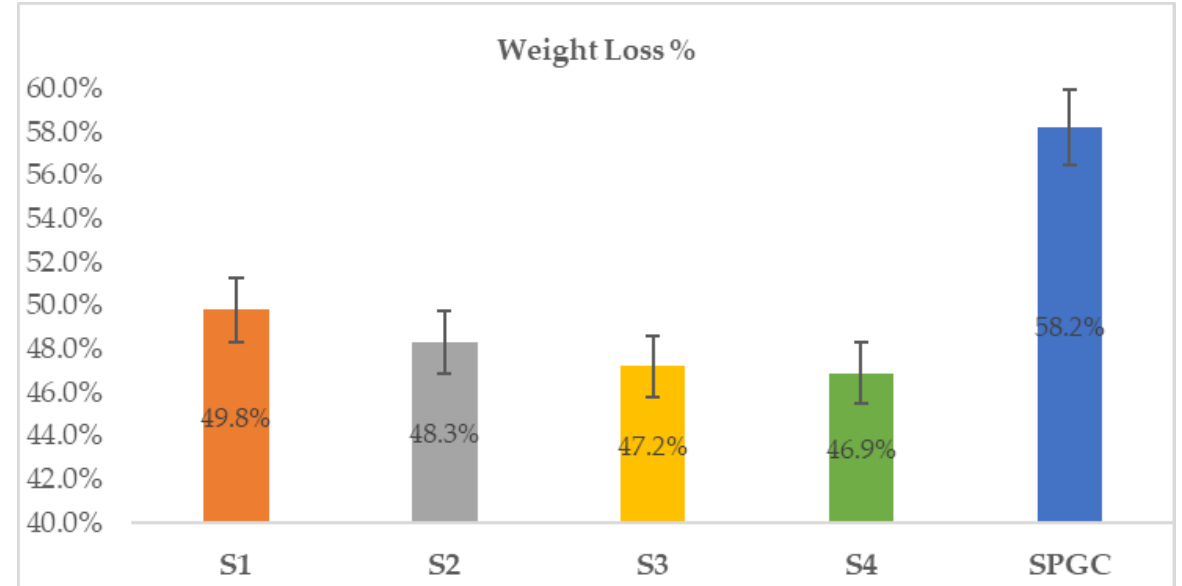
10 of 18 Figure 7. Comparison of the starch-based film (SPGC) and the samples (S1–S4) with nZnO gel frac- tion percentage. 3.5. Weight Loss The starch/polyvinyl alcohol/citric acid/glycerol films’ (S1–S4) weight loss with and